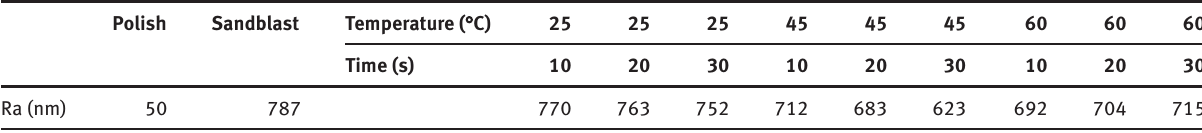
Table 4 Average result of surface roughness (Ra).